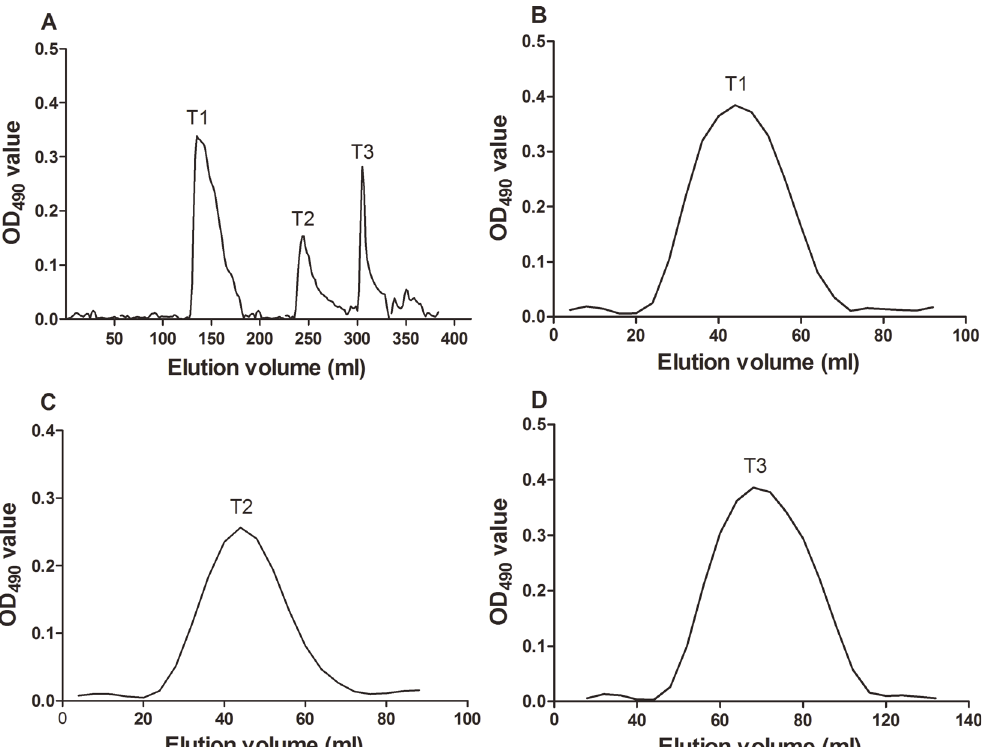
Fig 1. Isolation and purification of polysaccharides. (A) Ion exchange chromatogram of TPPPS on DEAE-cellulose column, eluted with distilled water, 0.01, 0.03, 0.05, 0.1, and 0.3 M NaCl. T1: TPPPS1; T2: TPPPS2; T3: TPPPS3. (B, C, and D) Gel filtration chromatogram of TPPPS1, TPPPS2, and TPPPS3, respectively, on Sephadex G-200 column eluted with 0.1 M NaCl.